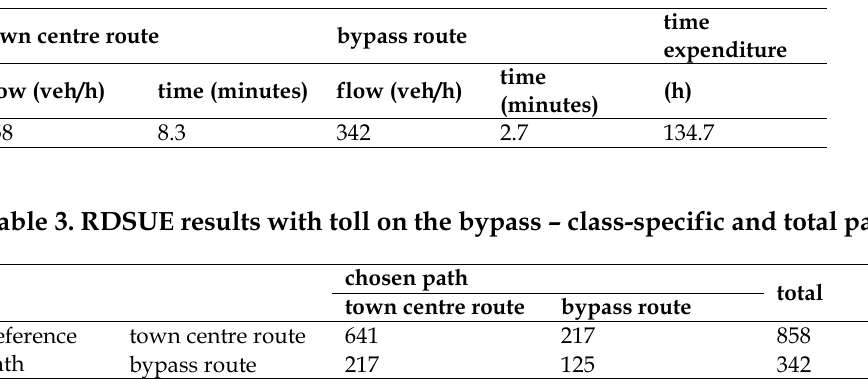
Table 2. RDSUE results with toll on the bypass